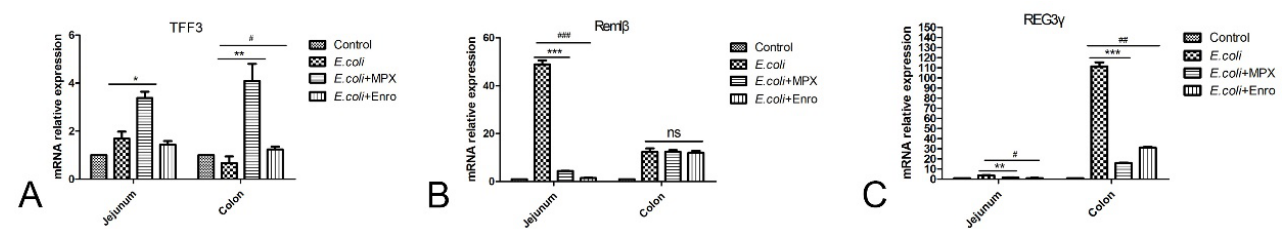
Fig. 3. The mRNA expression of the antibacterial protein in the mouse intestine. A: The mRNA expression of TFF3 in mouse jejunum and colon; B: The mRNA expression of Reml β in mouse jejunum and colon; C: The mRNA expression of REG3 γ in mouse jejunum and